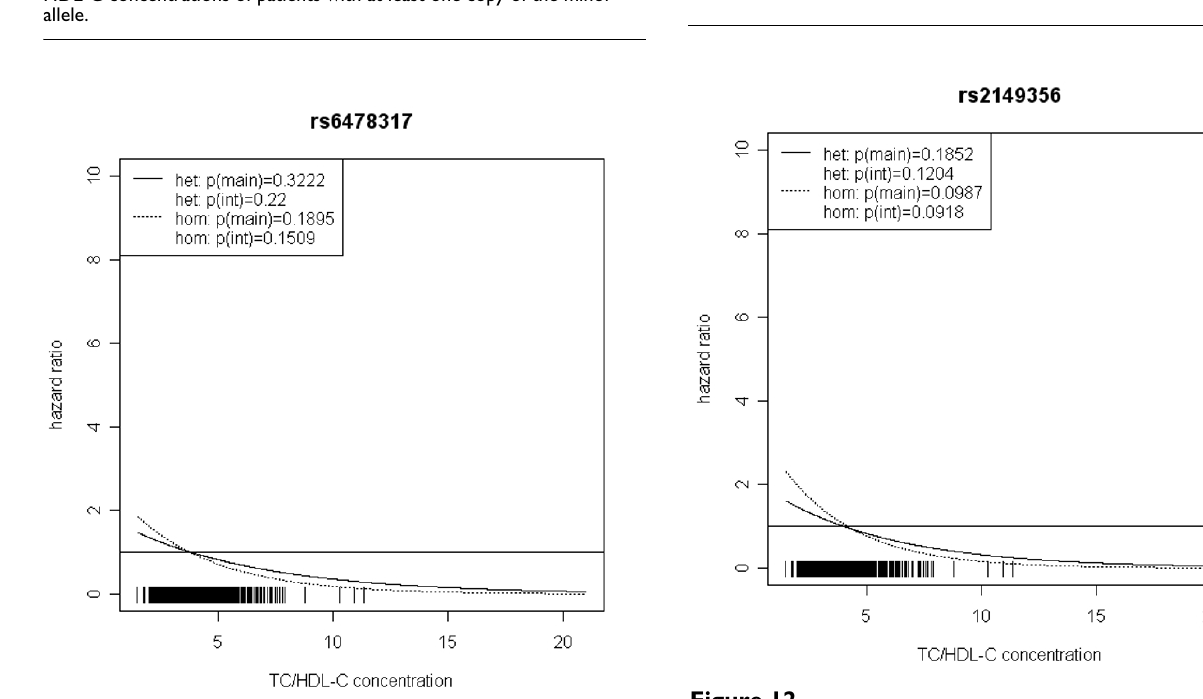
Figure 12 Hazard ratios of incident type 2 diabetes related to the respec- tive TC/HDL-C concentration in women for rs2149356 . Dashed lines represent subjects who are homozygote for the minor allele, while continuous lines show heterozygotes. Small bars at the x-axis indicate TC/ HDL-C concentrations of patients with at least one copy of the minor